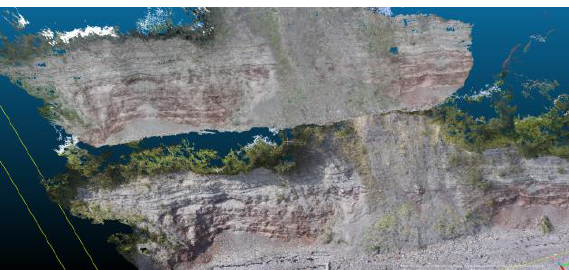
Figure 18. Like-to-like Alignment (Pole Survey up and Drone Survey